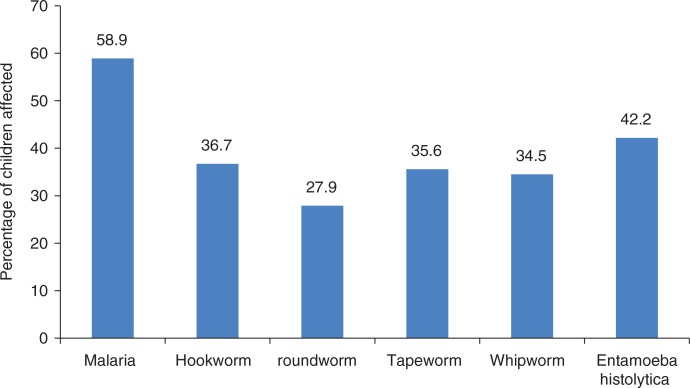
Percentage of the children affected by different species of parasitic infections.